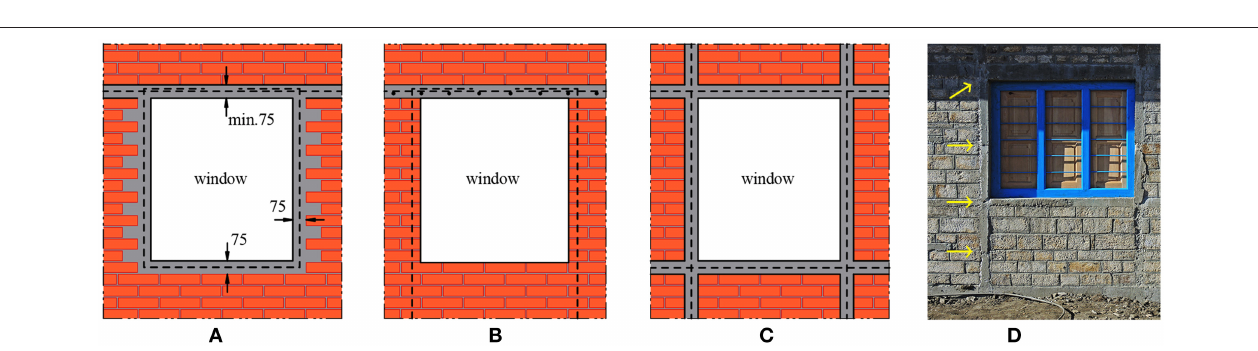
FIGURE 6 | Principles of boxing of openings with (A) concrete frames with shear keys (following IS 13828:1993, 1993). (B) vertical bars (following NBC 202:1994, 2007). (C) continuous vertical posts and horizontal beams (following NRA, 2018). (D) Practical example of vertical posts next to openings. ( A–C by courtesy of Smart Shelter Foundation, D by courtesy of